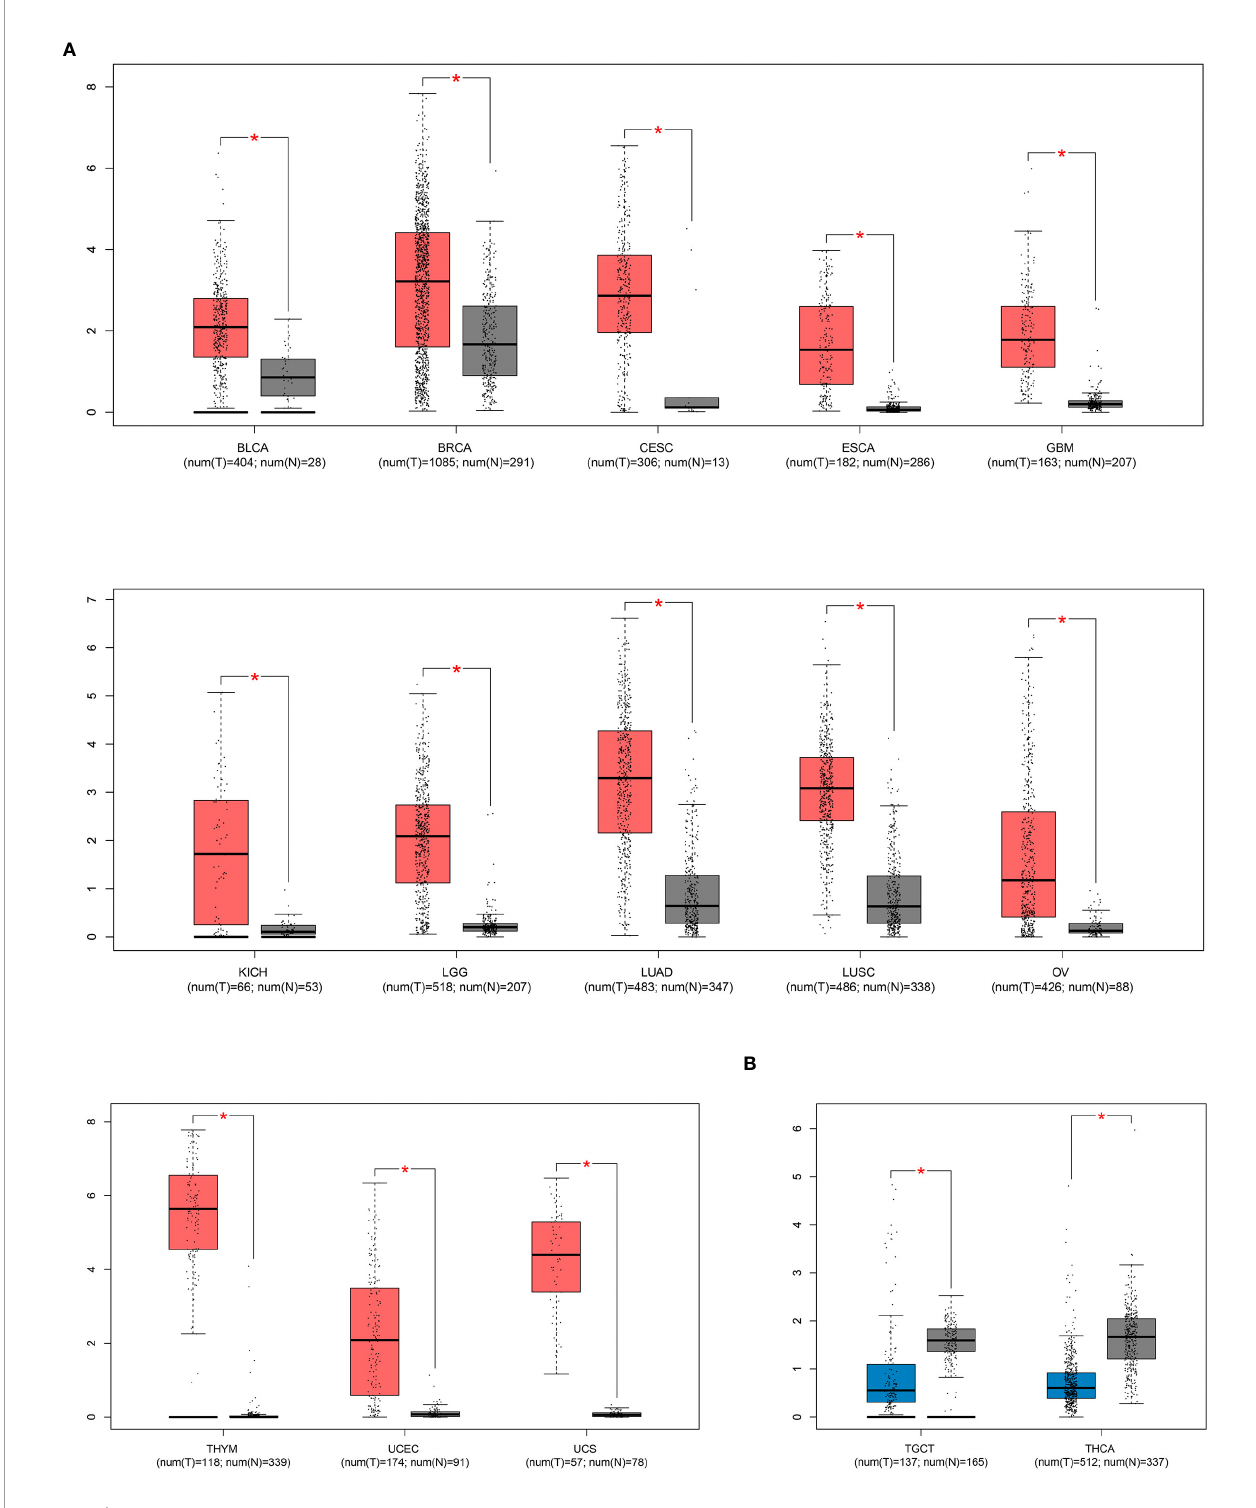
FIGURE 5 | TCGA data sets represent SIX1 aberrant expression levels in various cancer types. (A) . SIX1 overexpressed cancer types; (B) . SIX1 lower expressed cancer types. * means P value < 0.05 have statistical signi fi